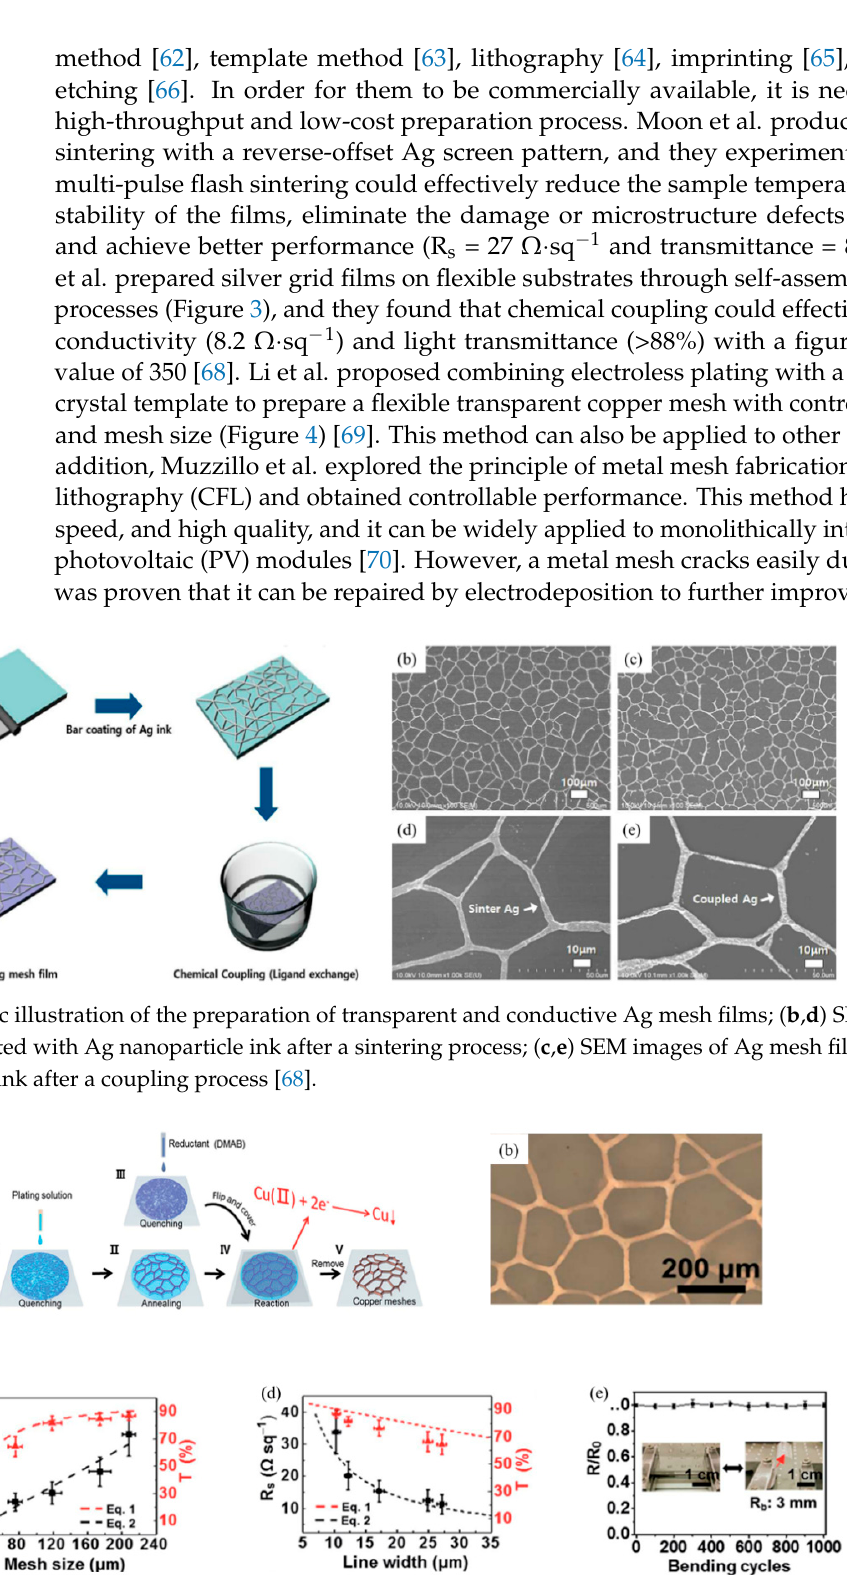
Figure 4. ( a ) Schematic illustration of the preparation of copper meshes on a flexible substrate; ( b ) SEM image of copper nanoparticles; ( c ) evolution of sheet resistance and transparency at 550 nm wavelength with mesh size; ( d ) evolution of sheet resistance and transparency at 550 nm wavelength with line width; ( e ) sheet resistance variation (R/R 0 ) versus the number of cycles of repeated bending to a radius of 3 mm [69].